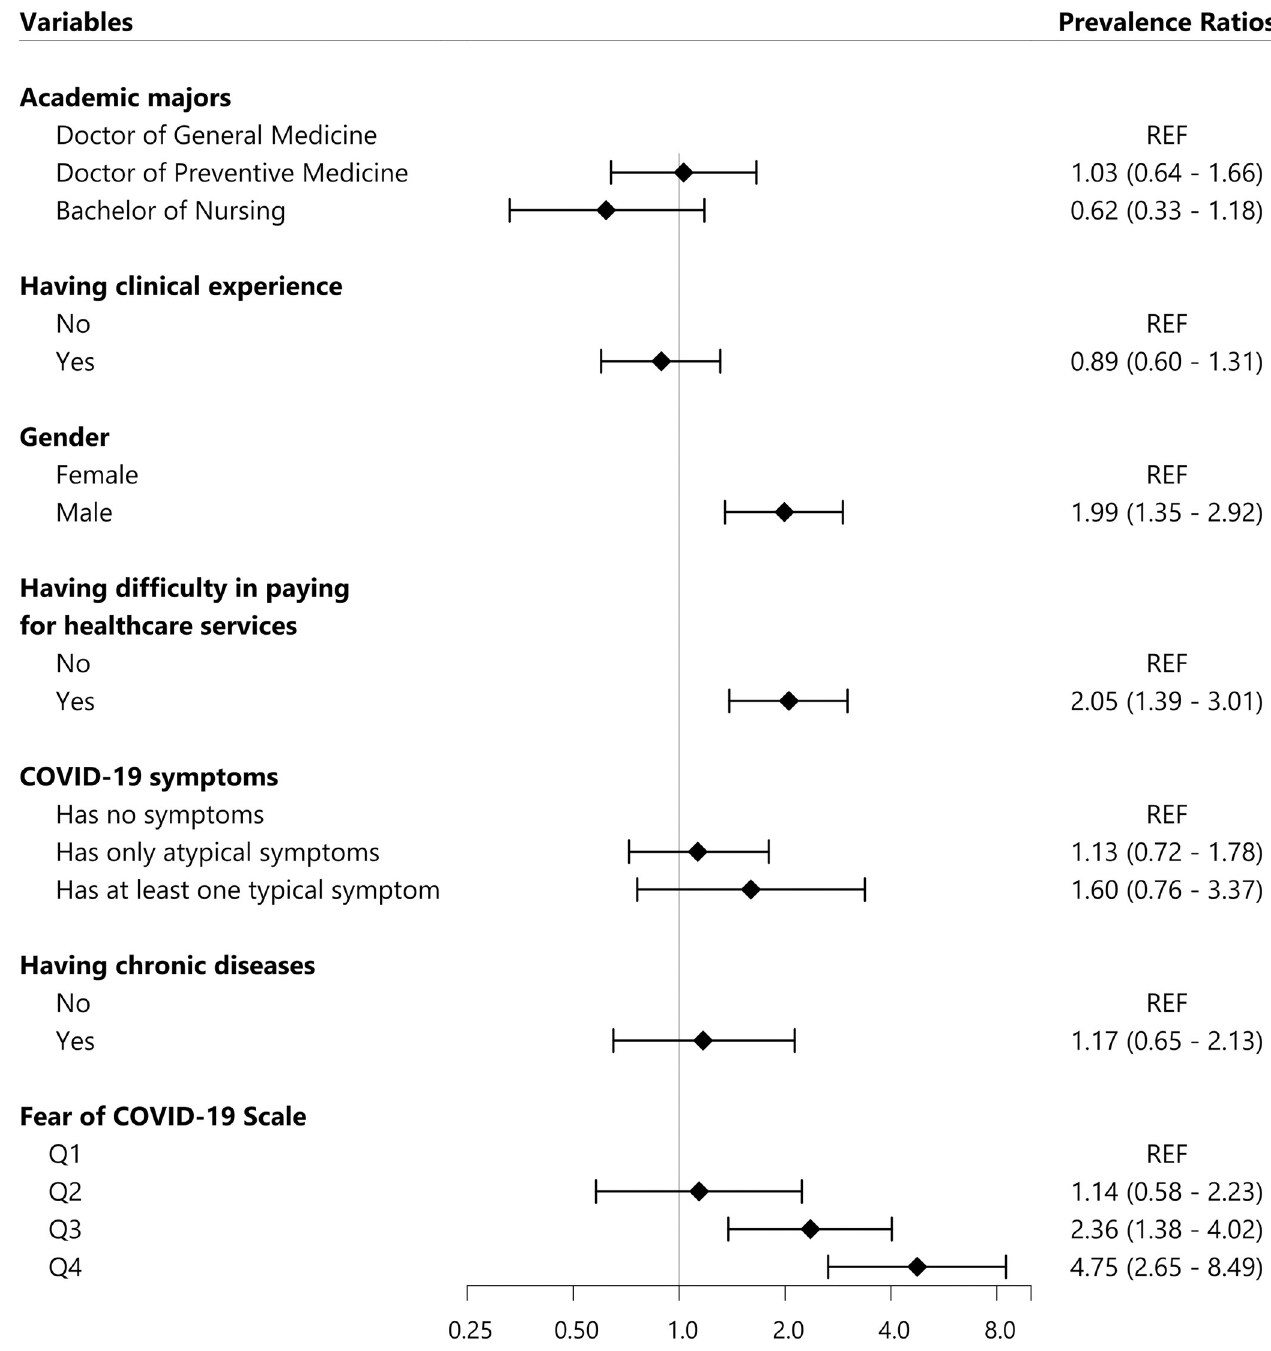
Fig 1. Factors associated with self-reported anxiety disorder. All Prevalence Ratios were adjusted using Poisson multivariate regression model. REF: Reference value, COVID-19: Coronavirus Diseases of 2019, the FCoV-19S score was divided into four groups based on quartiles: Q1, Q2, Q3, and Q4. Q1 group contained 25% participants with the lowest score from 7 to 13 points; Q2 group consisted of 25% participants with medium low score from 14 to 20 points; Q3 group was 25% participants with medium high score from 21 to 27 points; Q4 group was 25% participants with highest score from 28 to 35 points.